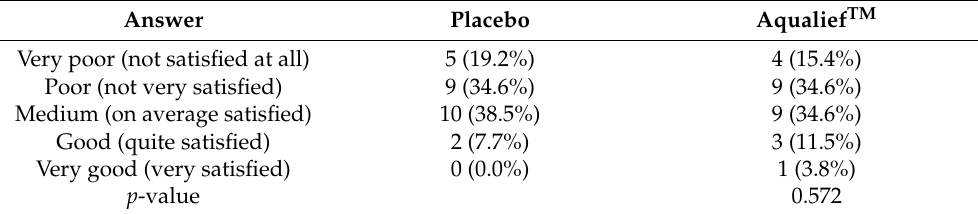
Table 3. Summary and Analysis of Patients’ Global